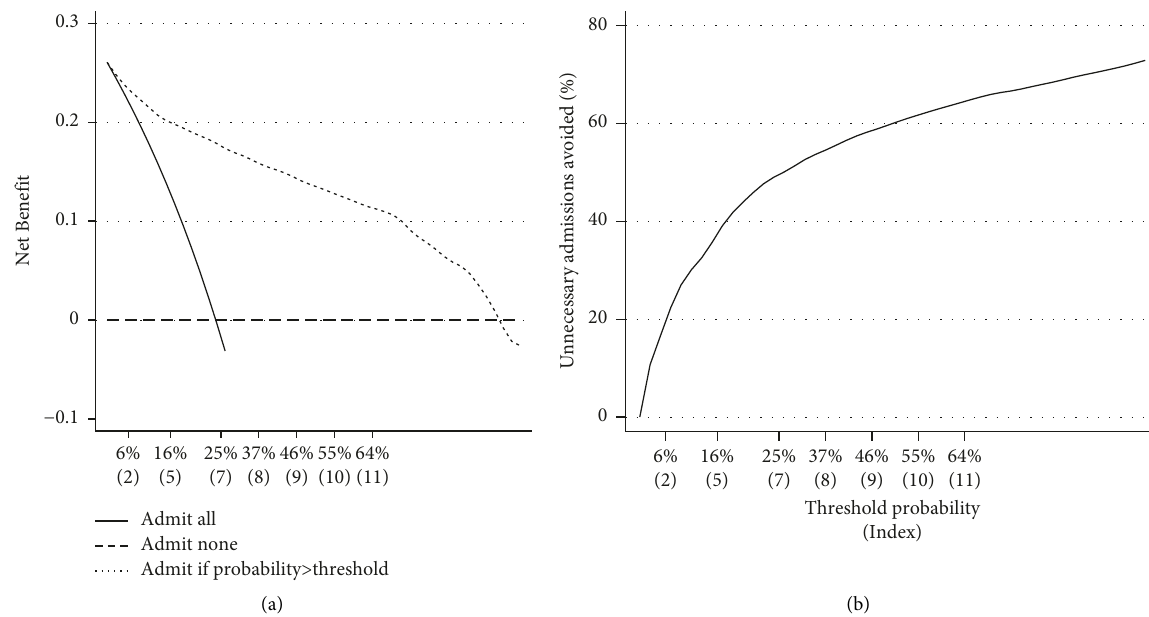
Figure 4: Decision curves. Net benefit (a) and number of interventions avoided (b) in the validation cohort. Y -axis represents the threshold probability of hypoxaemia or death given by the prognostic index score, which is mentioned below between brackets.